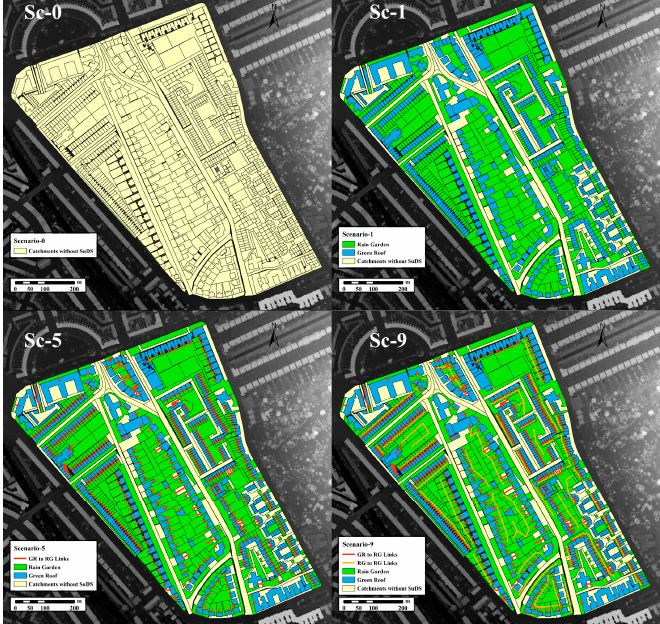
Figure 5. Sketch maps of different connection strategies. In scenario 1, neither RG or GR is connected; scenario 5, 526 GRs are connected to nearby RGs; scenario 9, 526 GRs are connected to nearby RGs and 422 RGs are connected to nearby RGs.